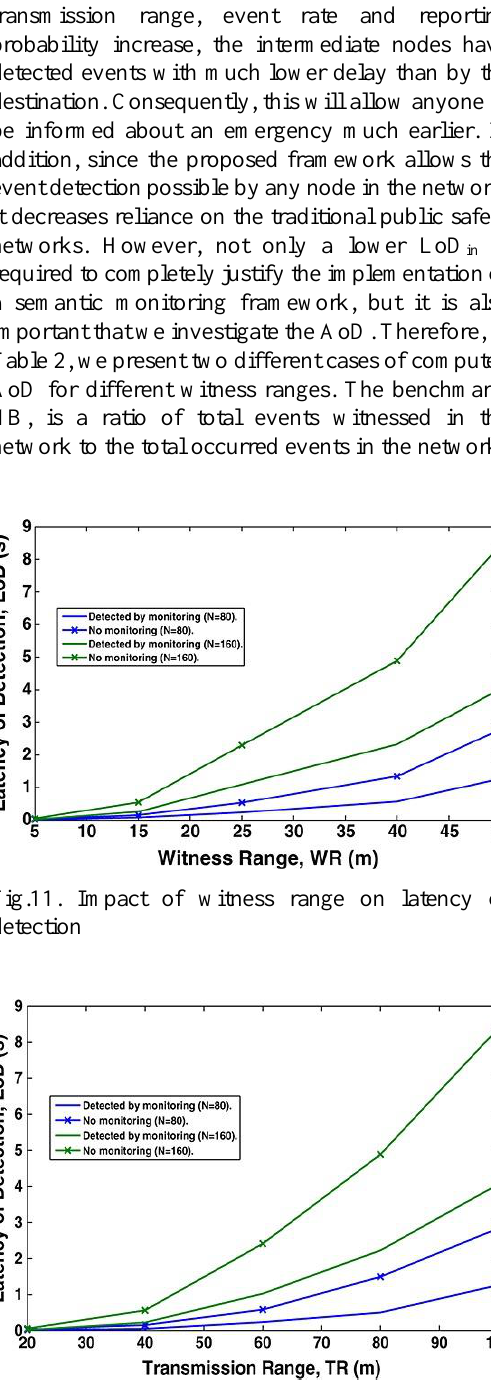
Fig.12. Impact of transmission range on latency of detection